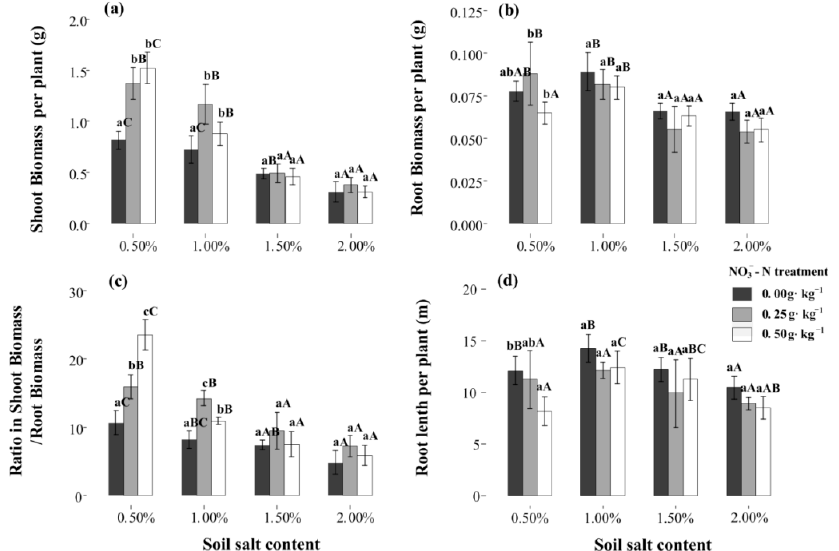
Figure 1. Effects of NO − -N treatments on Suaeda salsa grown at different salt levels. ( a ) Shoot biomass, ( b ) root biomass, ( c ) shoot/root ratio, and ( d ) root length. Capital letters indicate significant differences among the four salt levels. Lowercase letters indicate significant differences among the three NO − -N treatments.